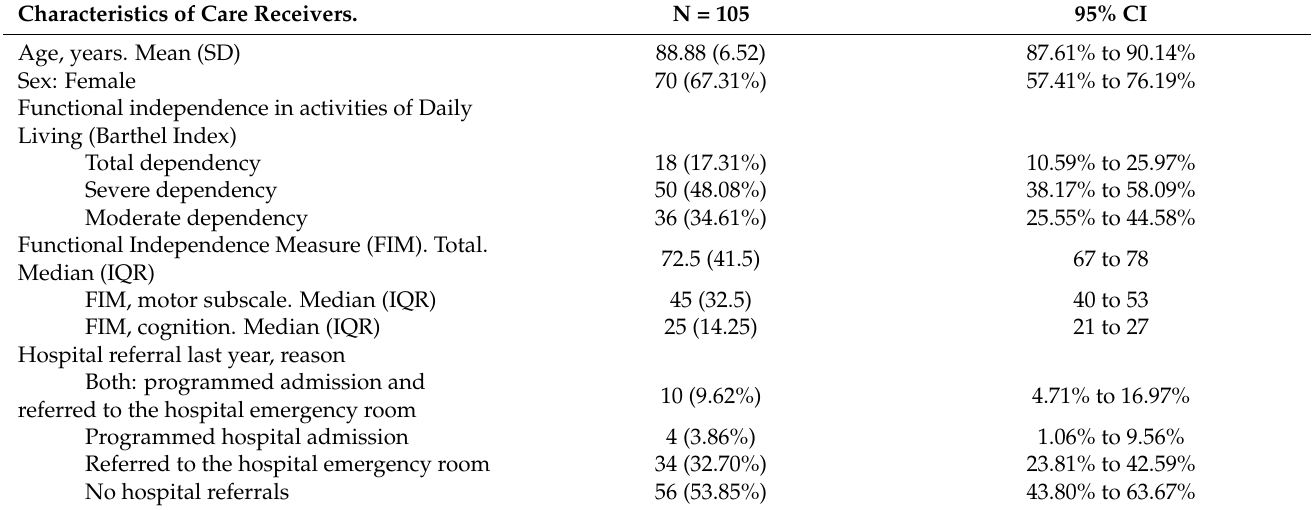
Table 4. Characteristics of care receivers.